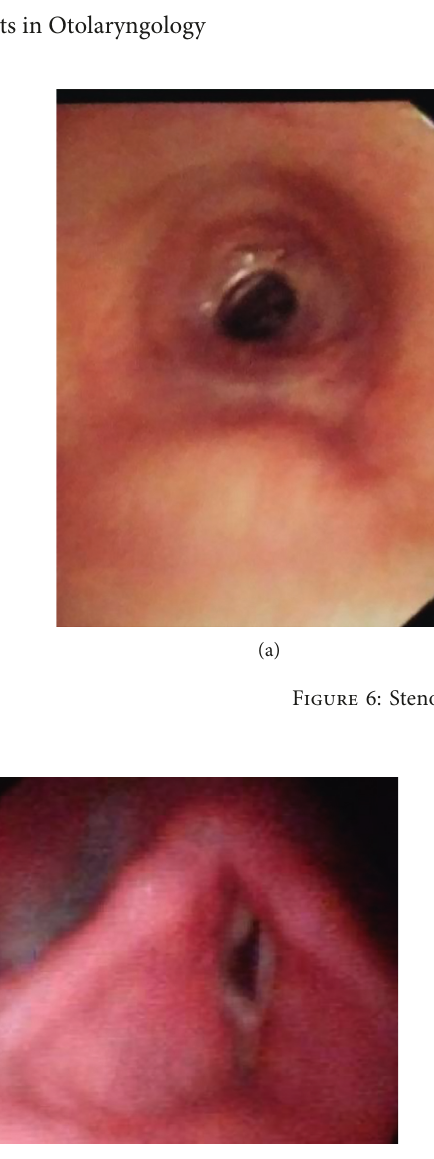
Figure 7: Postoperative image of Kashima’s